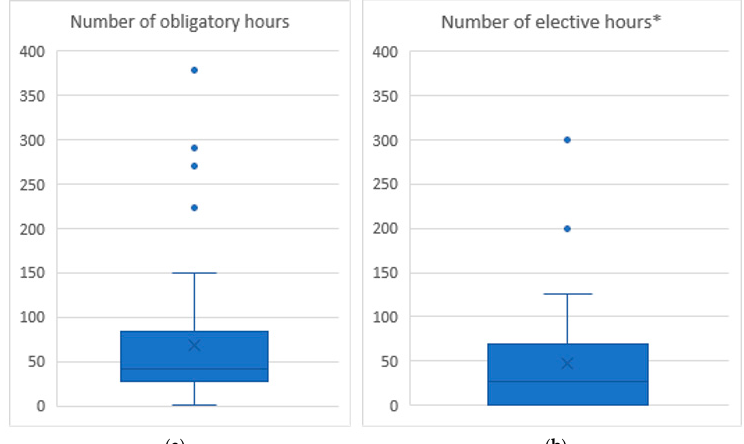
Figure 2. The number of ( a ) obligatory and ( b ) elective hours delegated to animal welfare studies within the curriculum (boxes indicate the second and the third quartiles; bars denote the median; x denotes the average value, whiskers indicate the 5th and 95th centiles; dots denote outliers). * Data available for only 30 VEEs, as not all had